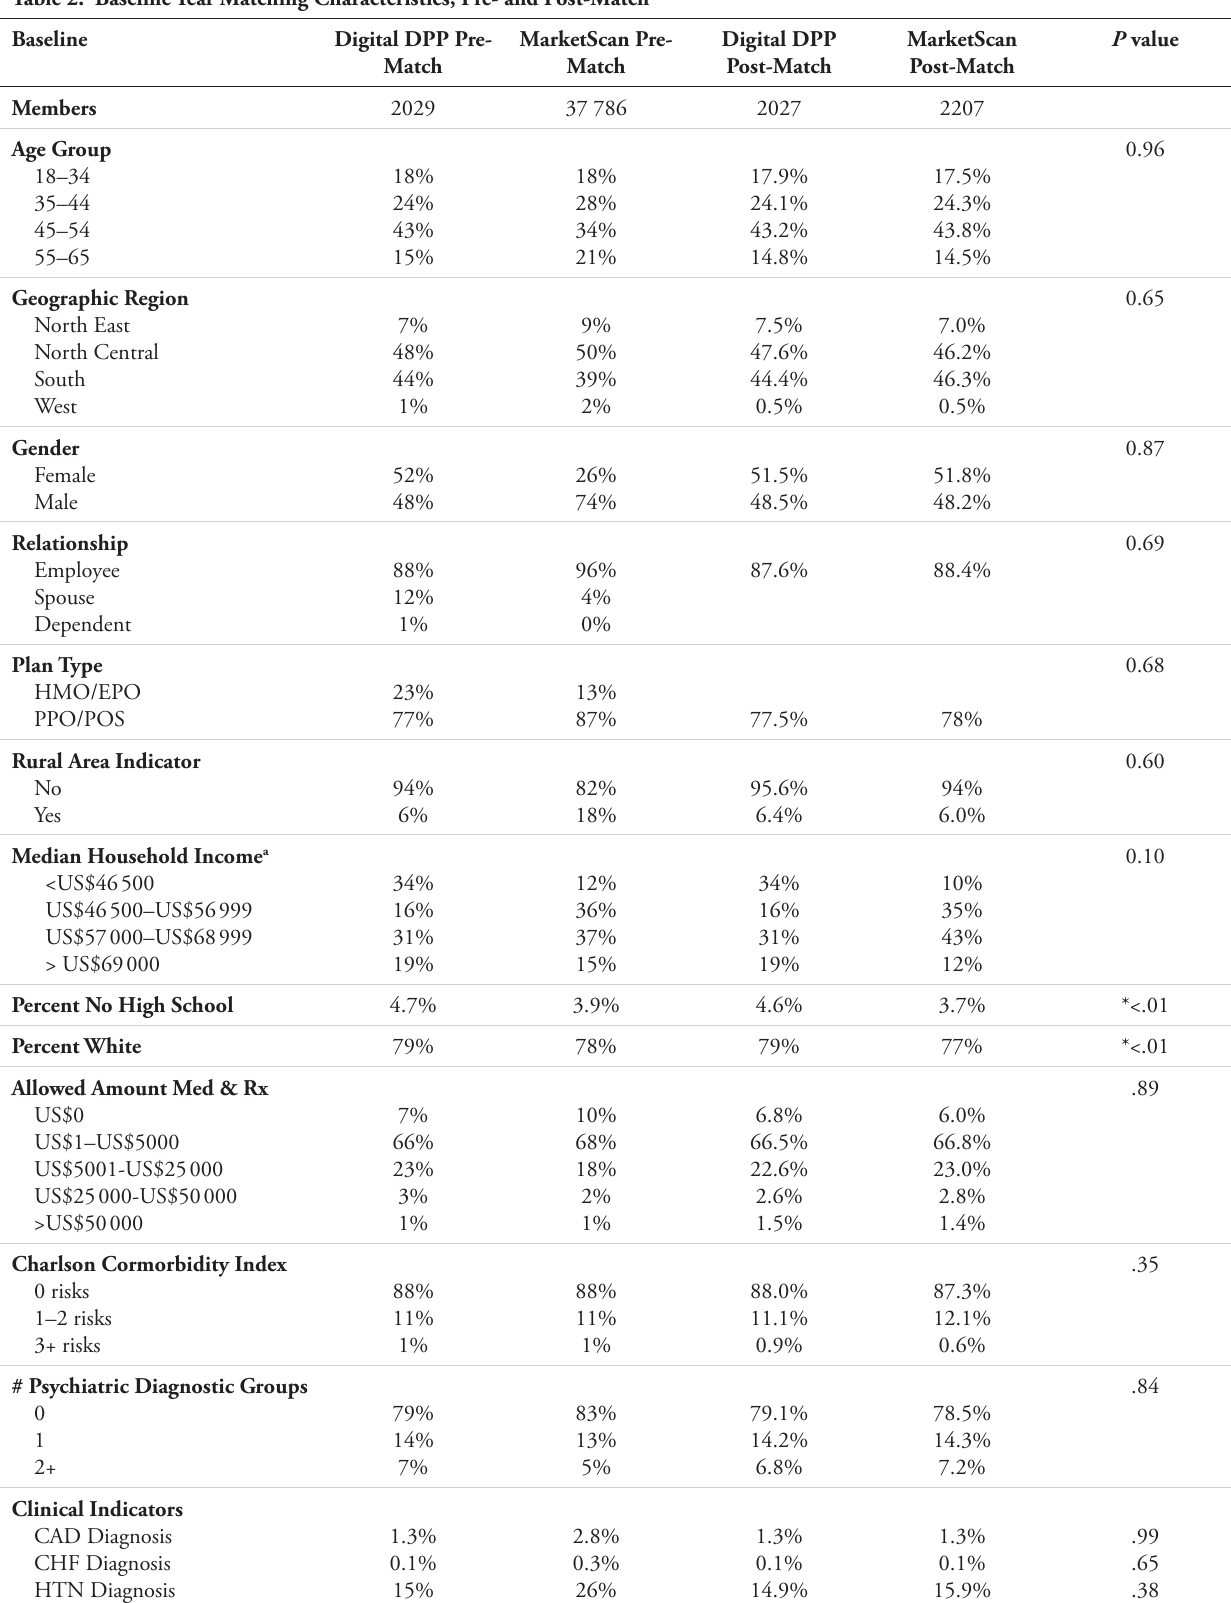
Table 2. Baseline Year Matching Characteristics, Pre- and Post-Match